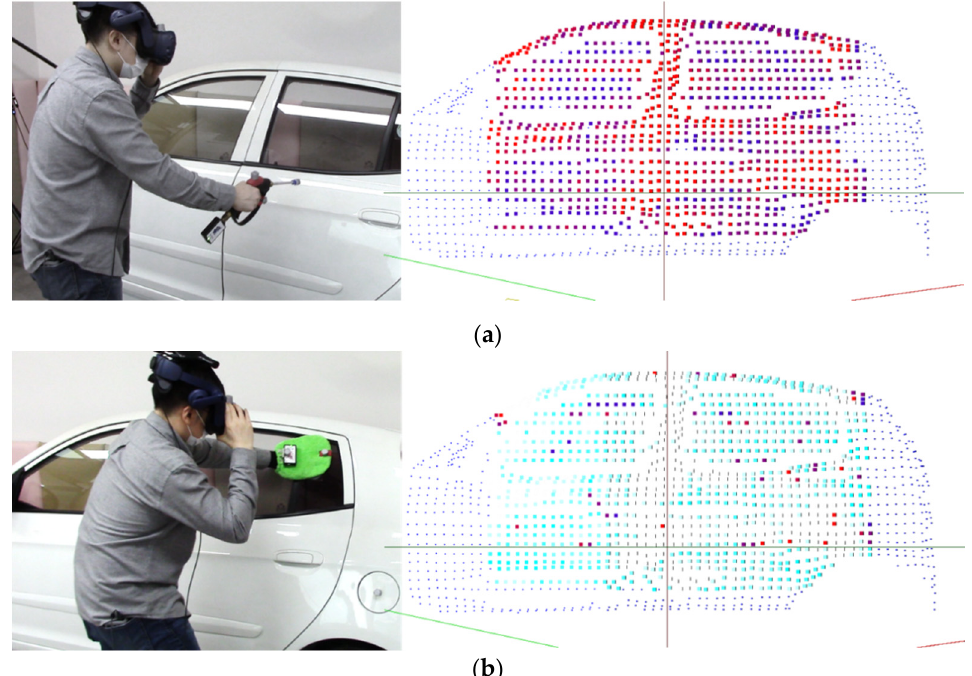
Figure 17. Changes in the sampling points: ( a ) Stem-spraying; ( b ) Mop-wiping.